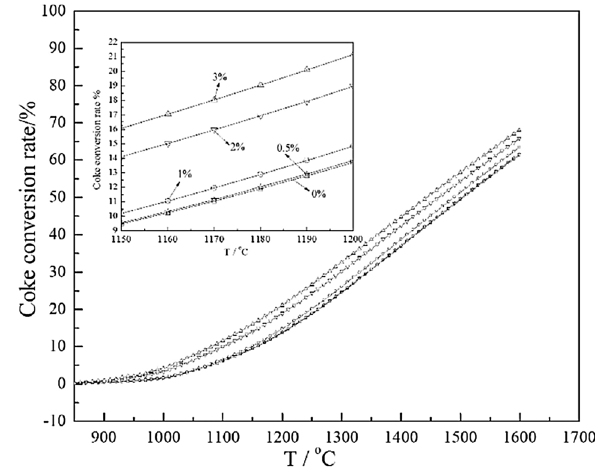
Fig. 4 The effect of catalytic salt on the carbon conversion